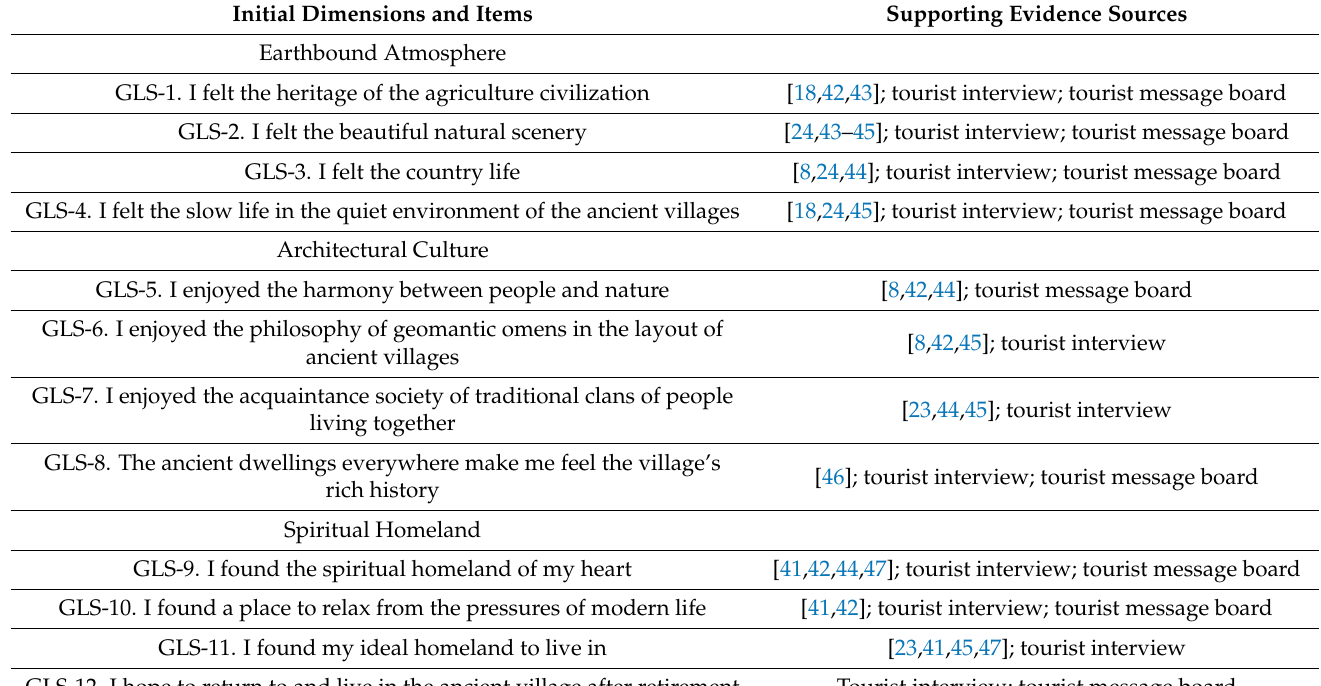
Table 1. Supporting evidence sources of initial genius loci dimensions and